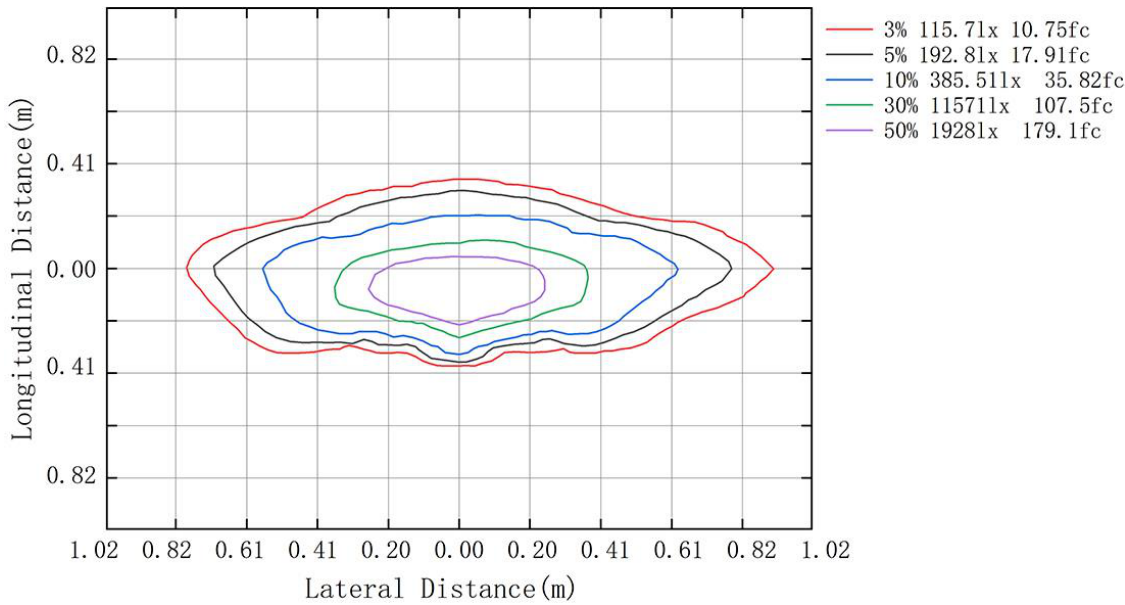
Figure 6. Isoilluminance diagram of the light source.